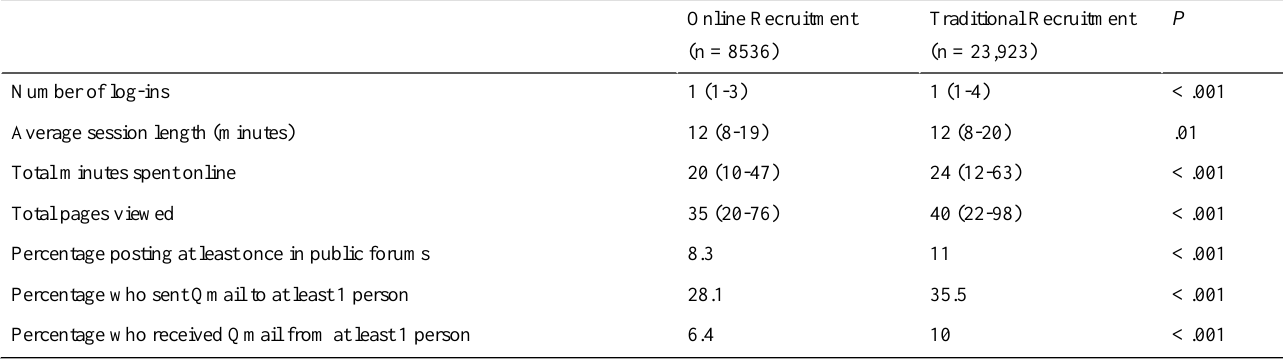
Table 2. Median (interquartile range) of QuitNet utilization among online and traditional media responders a